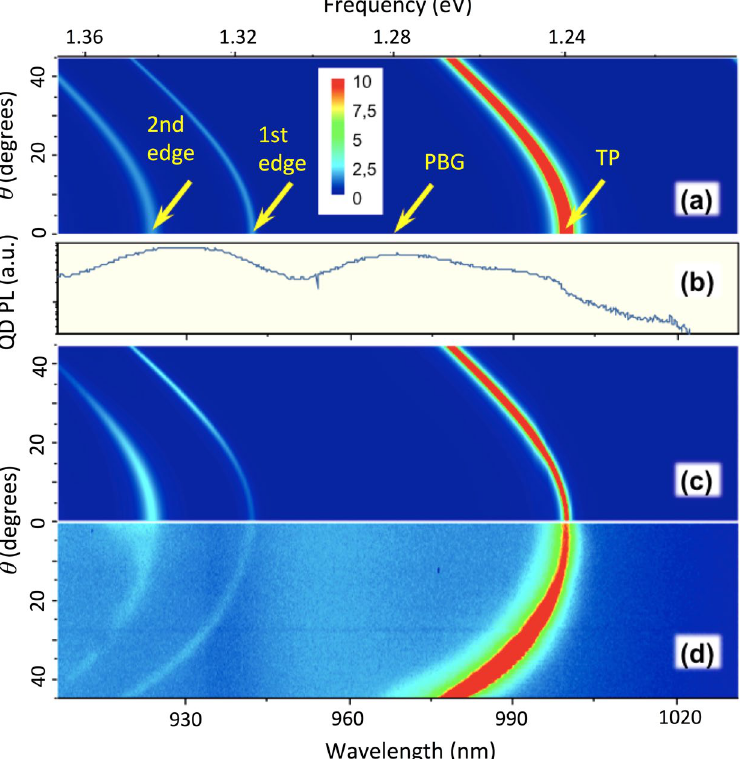
Figure 2. ( a ) Dependence of the calculated modal Purcell factor on frequency and angle of emission; ( b ) Emission spectrum of quantum dots; ( c ) Dependence of the product of the calculated modal Purcell factor and the emission spectra of quantum dots on frequency and angle of emission; ( d ) Experimentally measured photoemission spectra. Arrows mark the modes (TP –Tamm plasmon, PBG – photonic band gap, 1 st edge – 1 st edge state, 2 nd edge – second edge state).